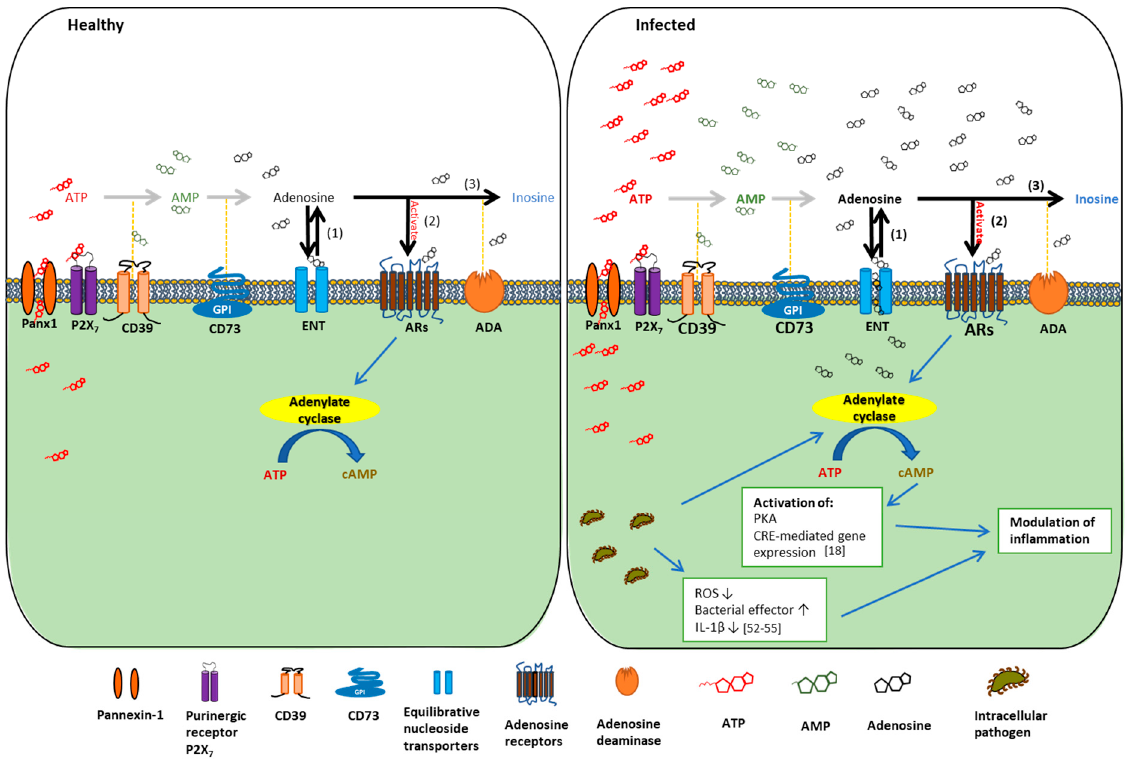
of inflammation.